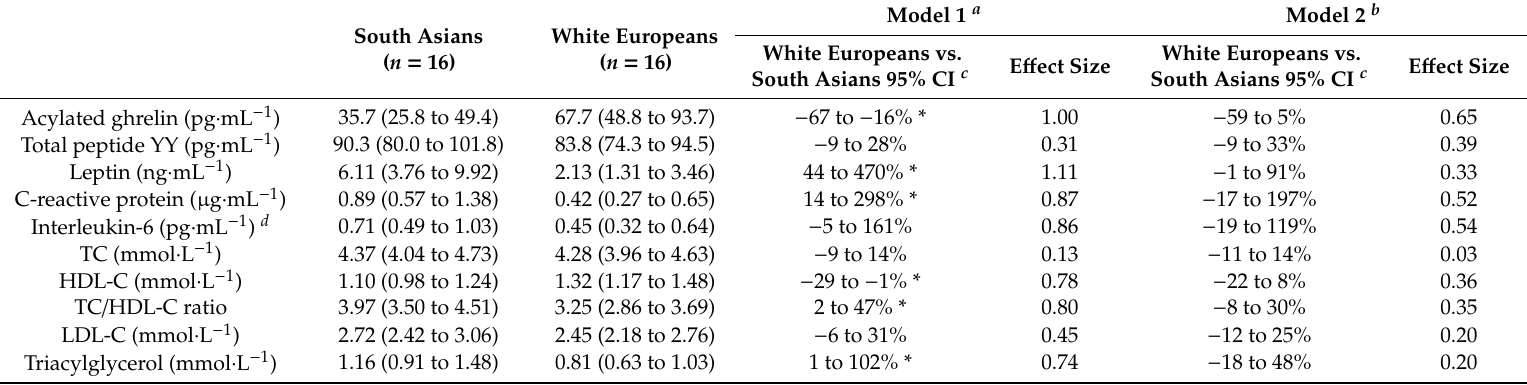
Table 3. Fasting plasma concentrations in South Asian and white European men.